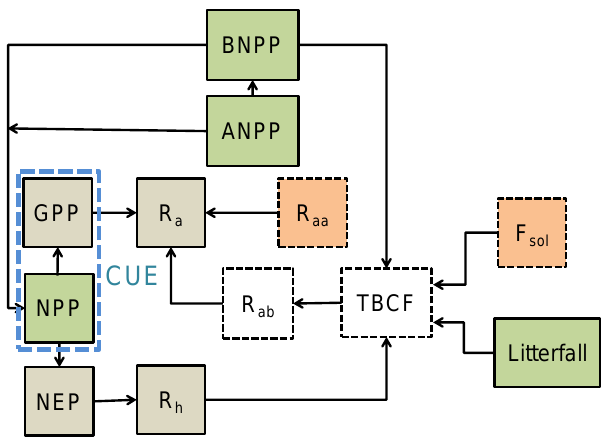
Figure 1. Method used in closing the whole-ecosystem carbon bal- ance. Arrows are the information lines. The grey boxes surrounded by a continuous line are the ecosystem scale flux measurements yielding NEP, GPP and R eco values. The green boxes are the con- tinuous biometric measurements of the growth components. The boxes surrounded by a dashed line mean discrete measurements. The brown boxes are discrete measurements of fluxes (from leaf, stem and soil) upscaled in time and space.